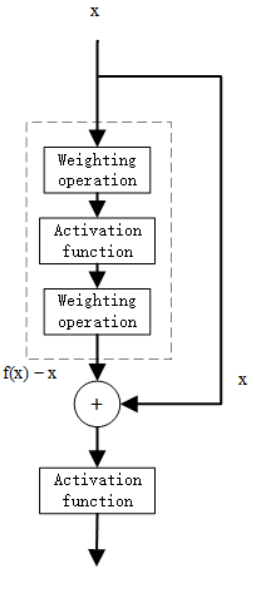
Figure 4. Residual module structure.